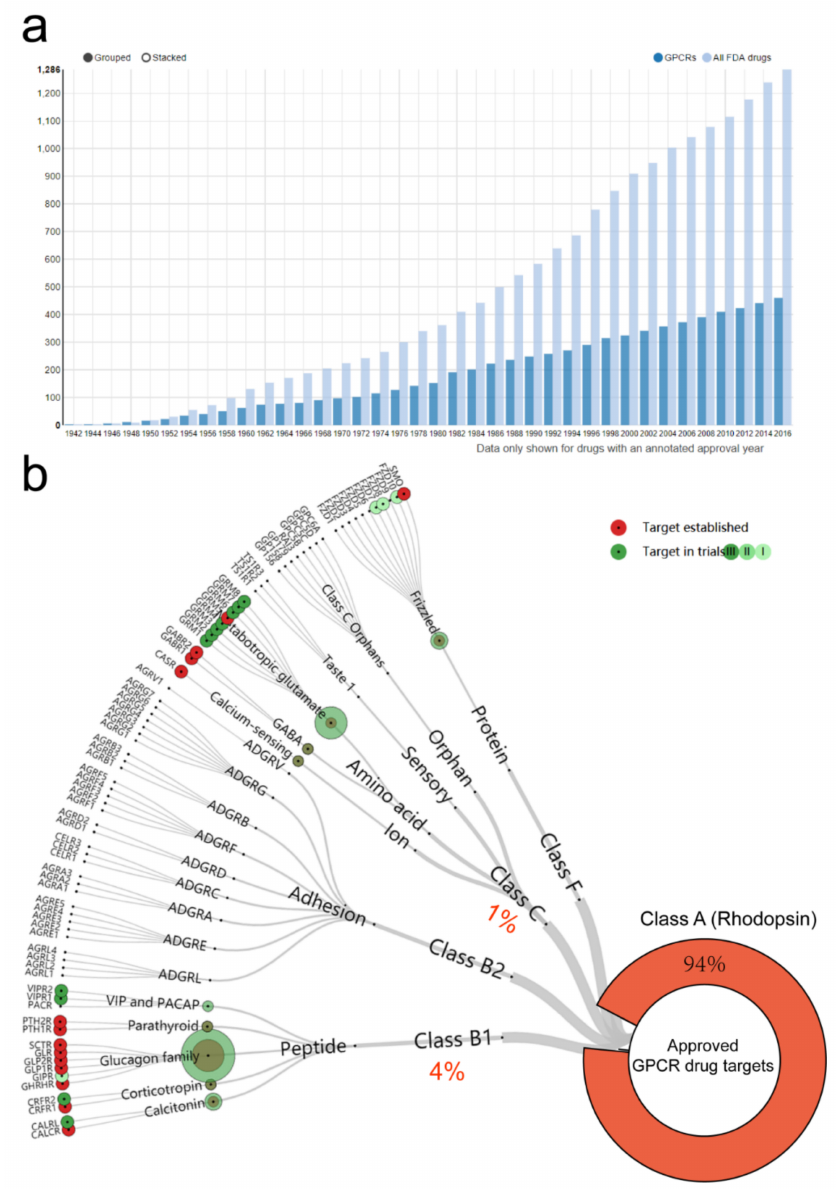
Figure 1. Research status of GPCR drug targets. ( a ) GPCRs share ~30% of FDA-approved drugs. Data are only shown for drugs with an annotated approval year and downloaded from https://www.gpcr db.org/drugs/drugstatistics (last accessed on 12 April 2022). ( b ) The interactive tree that includes the number of agents for each target is downloaded and modified from http://www.gpcrdb.org/d rugs/drugmapping (last accessed on 12 April 2022) [1,8,9]. Approved drugs (red) and phase I–III (green). The sizes of the circles represent the number of